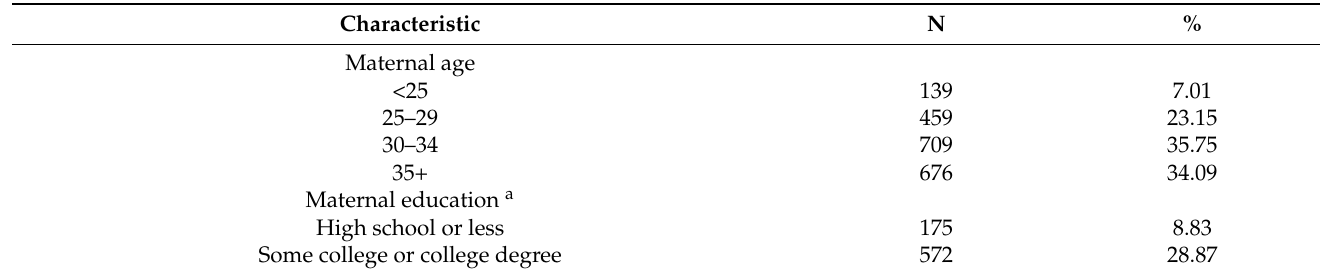
Table 1. Descriptive characteristics of participants in the Maternal-Infant Research on Environmental Chemicals (MIREC) Study, N = 1983 pregnant